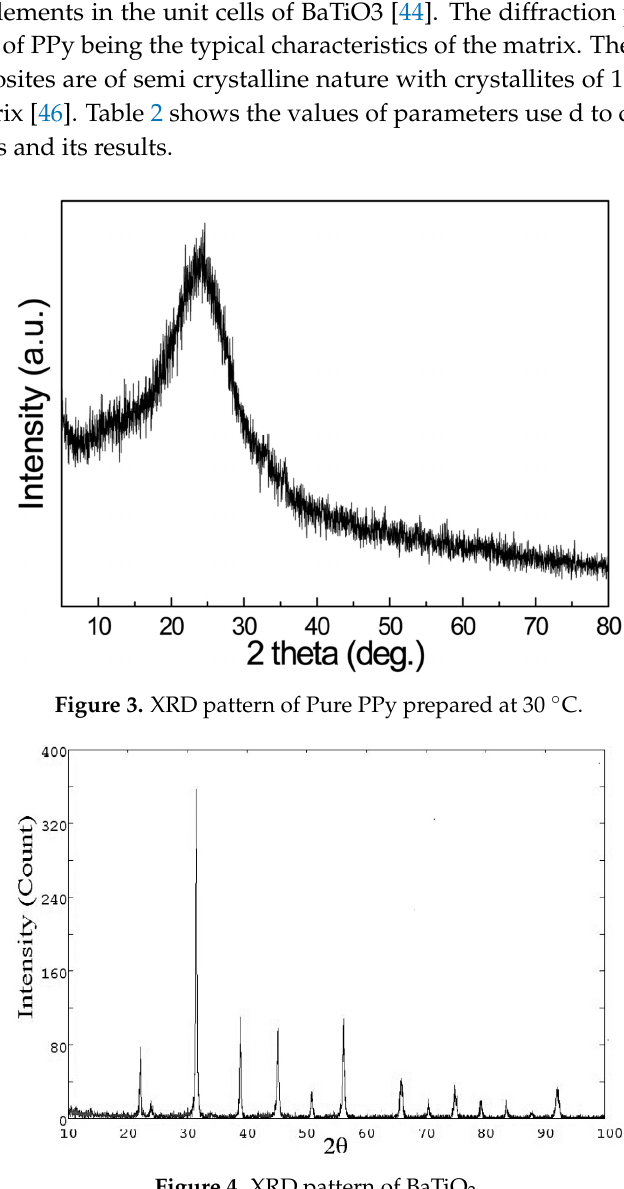
Figure 4. XRD pattern of BaTiO 3 .